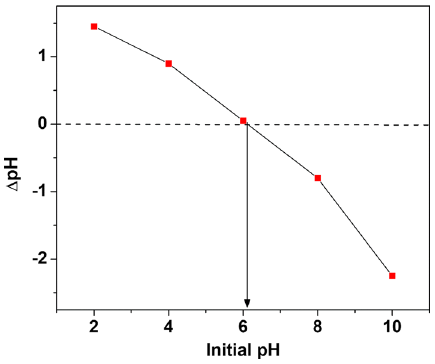
Fig. 5 Point of zero charge analysis of CTAB–kaolin